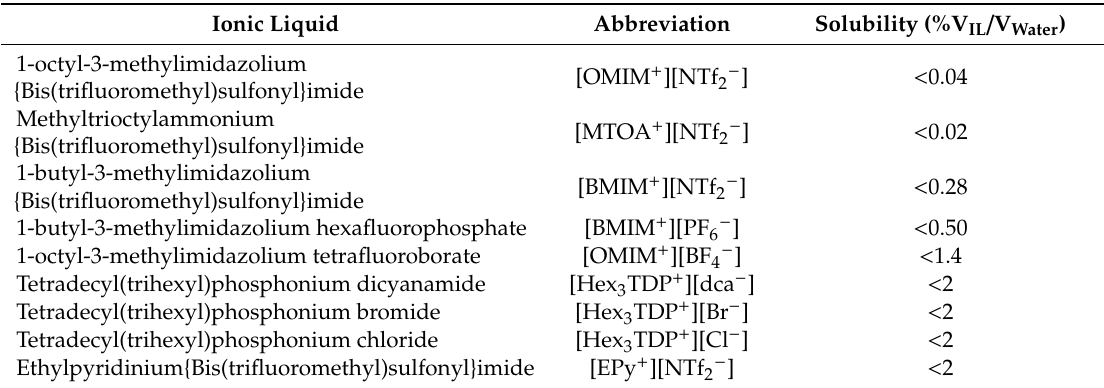
Table 8. Selection of ionic liquids and their water